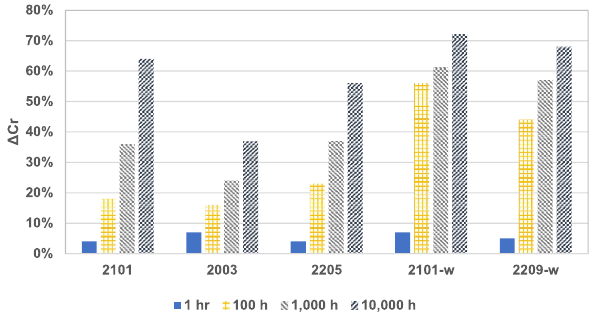
Fig. 3 ΔCr from the APT measurements for each alloy as a function of